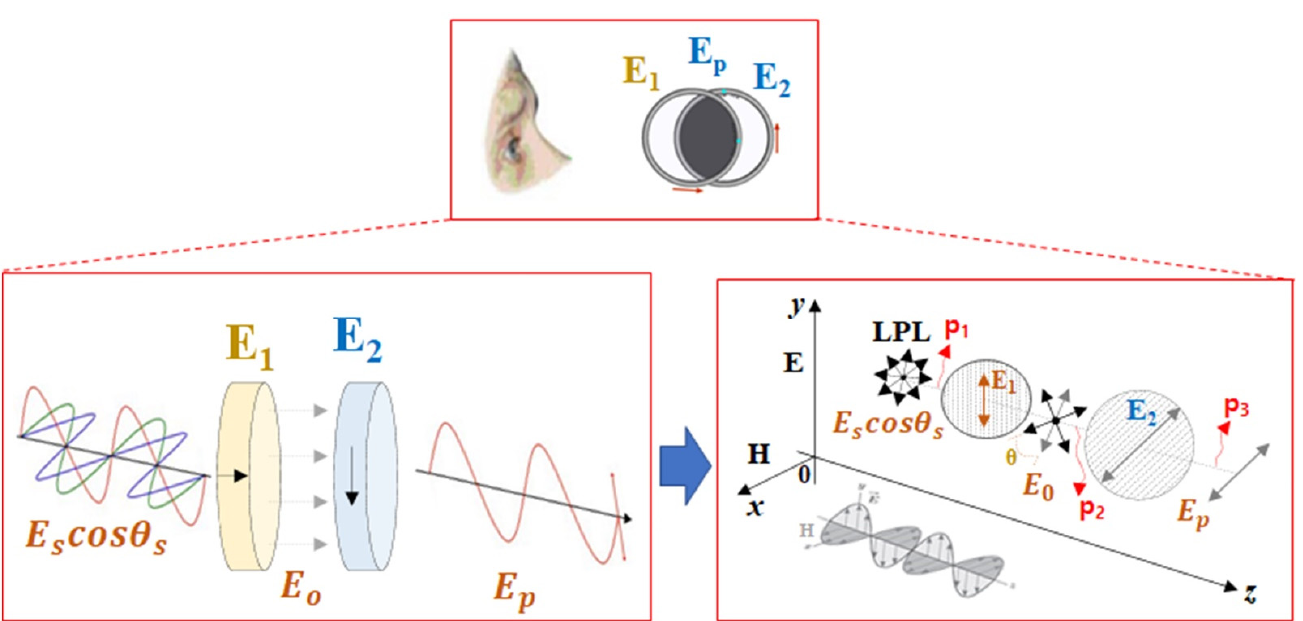
Figure 3. Analysis of specular removal though the linear polarized filtering.